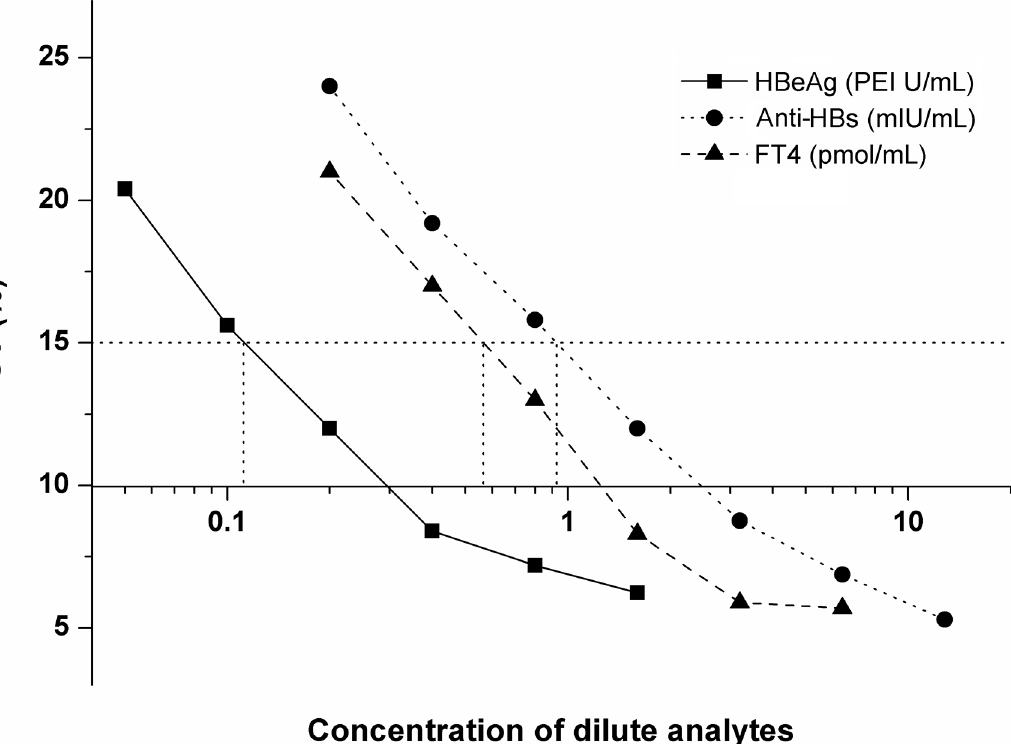
Fig 3. Functional detection limits of HBeAg, Anti-HBs and FT4 were the lowest analyte concentration that could be measured with a CV of 15% or less in ten replica measurements.